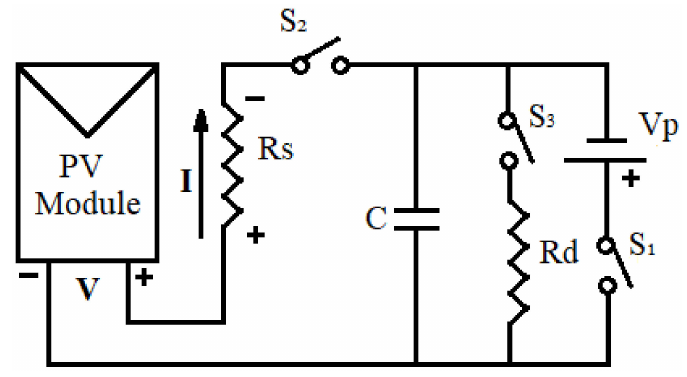
Figure 2. Electrical diagram of the proposed I–V curve